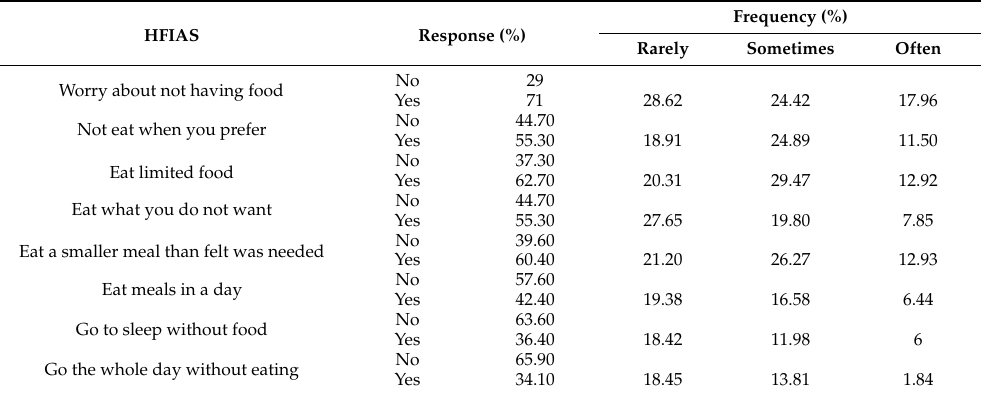
Table 5. Household Food Insecurity Access Scale